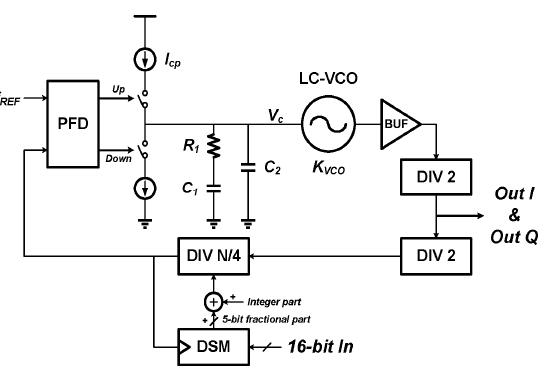
Figure 9. Block diagram of the fractional-N PLL, including the PFD, LPF, VCO and divider.